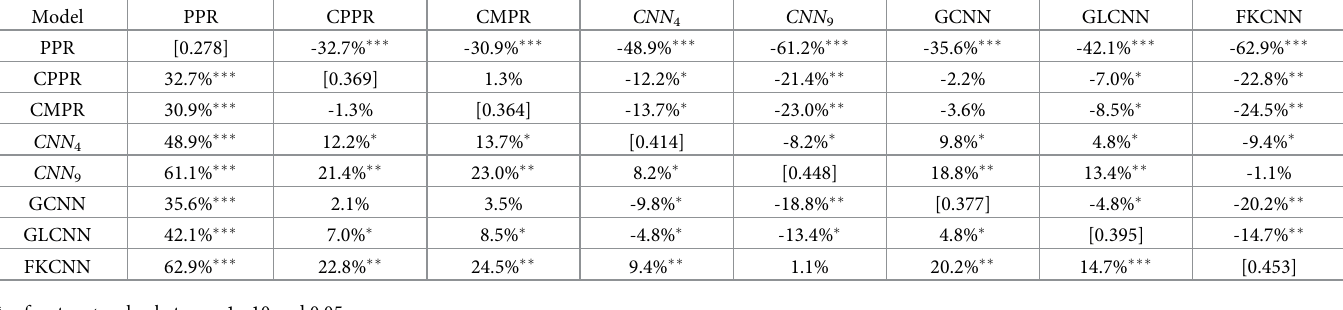
Table 1. Relative performance difference between the different methods on Monkey A. The average performance of all models are put on the diagonal of this table. The relative performance difference is calculated as (A-B)/min(A, B), where A is the average performance of the method on the row and B is that of the method on the